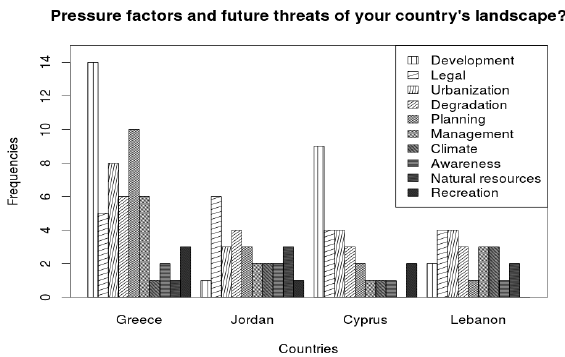
Figure 7. Frequencies of answers to the question “What do you consider to be the pressure factors and future threats of your country’s landscape?” by country of residence.